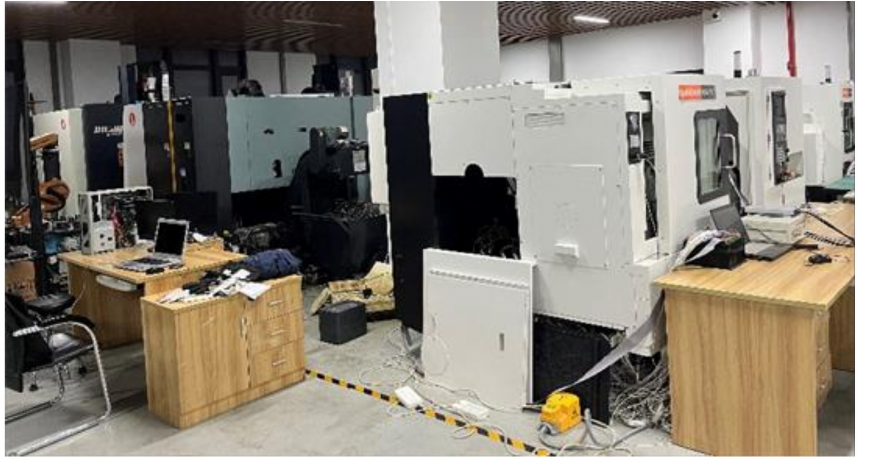
Figure 1. Discrete manufacturing